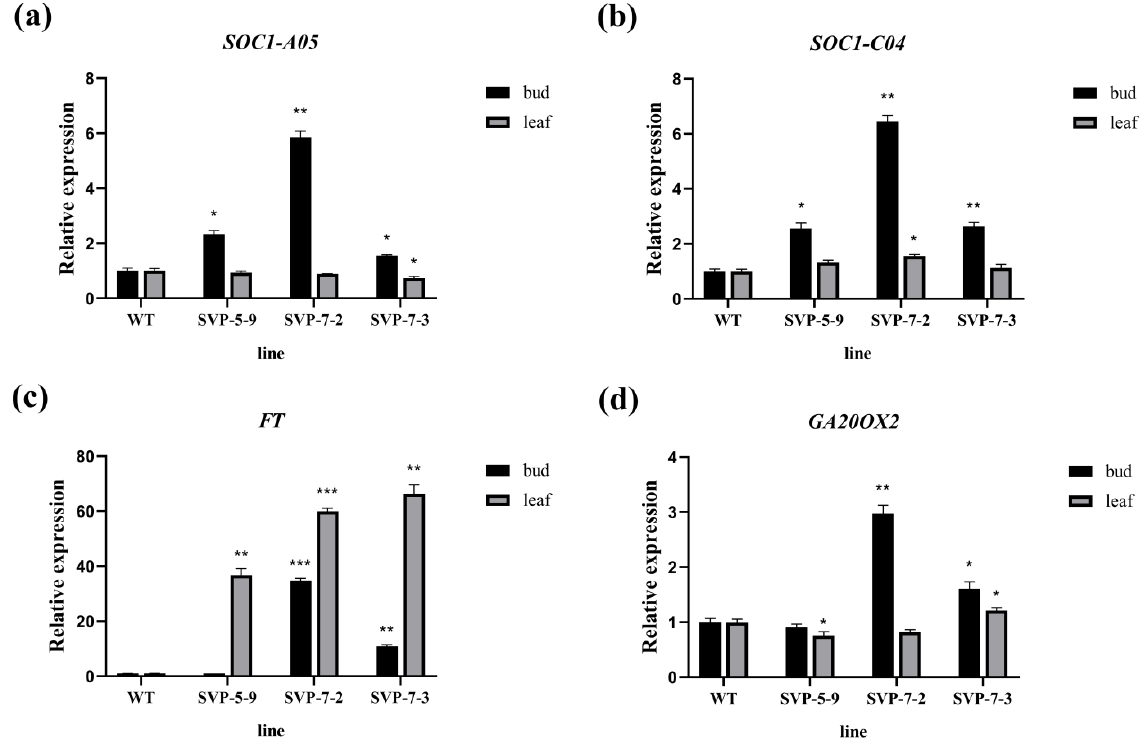
Figure 8. Fluorescence quantitative analysis of the SVP -related genes. ( a – d ) The relative expression levels of BnaA05.SOC1 , BnaC04.SOC1 , FT , and GA20OX2 in the svp mutant lines; * p < 0.05, ** p < 0.01, *** p < 0.001.